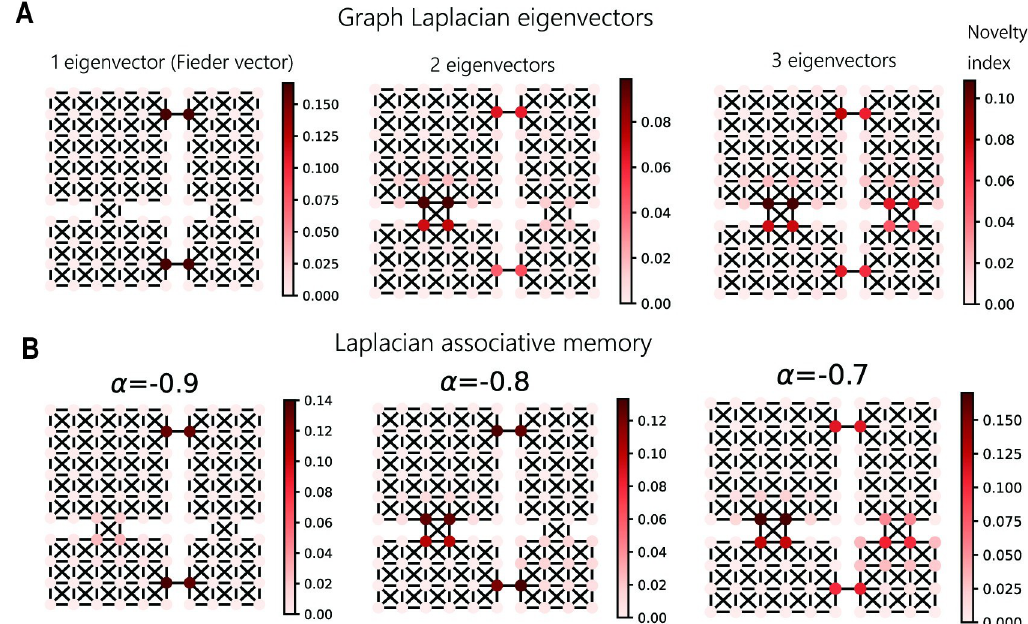
Fig 6. Subgoal finding by novelty detection with representations in LAM. (A) Subgoal finding using low-dimensional (1, 2, or 3) representations constructed from graph Laplacian eigenvectors. The color indicates the novelty index for each node. (B) Subgoal finding using representations in LAM obtained by different values of α